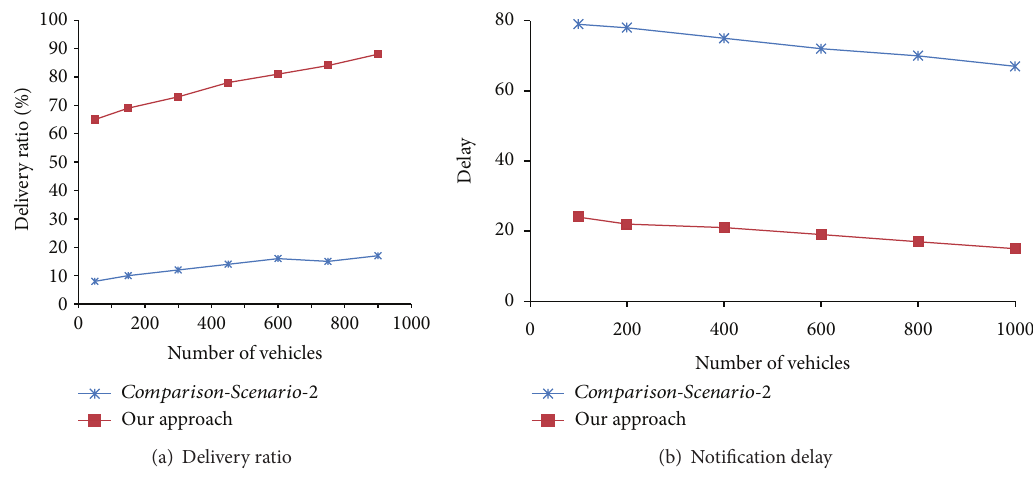
Figure 4: Our approach versus Comparison-Scenario-2